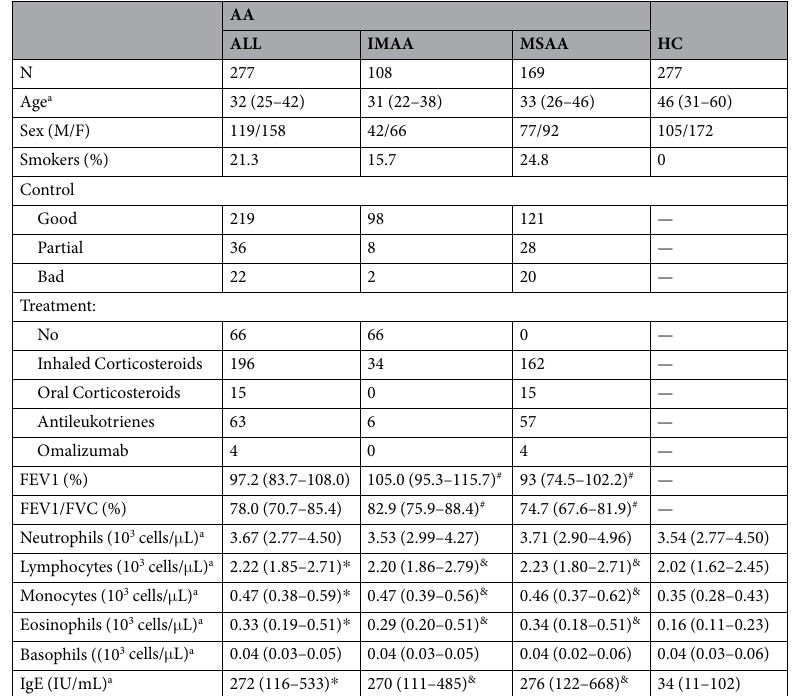
Table 1. Characteristics of the study population. AA, allergic asthmatics; HC, healthy controls; IMAA, intermittent-mild allergic asthmatics; MSAA, moderate-severe allergic asthmatics. a Median value (IQR1–3); * AA vs HC: Mann-Witney U Statistic, P < 0.001; # IMAA vs MSAA: Mann-Witney U Statistic, P < 0.001; & IMAA vs MSAA vs HC: Kruskal-Wallis One Way Analysis of Variance on Ranks (P < 0.001), IMAA/MSAA vs HC P < 0.05 Dunn’s